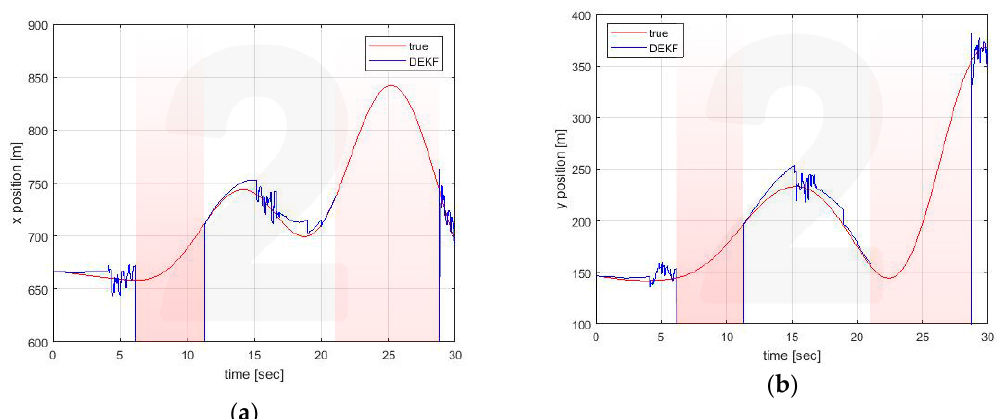
Figure 10. Position estimation performed by Vehicle 4 on Vehicle 2 position ( a ) x axis ( b ) y axis.